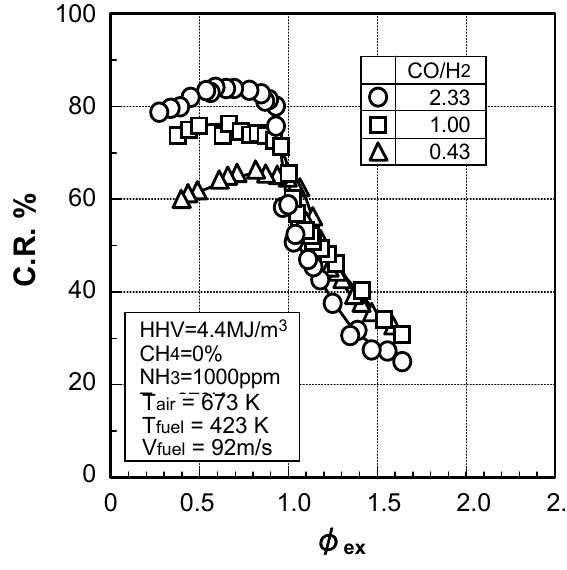
Figure 12. Effects of CO/H by